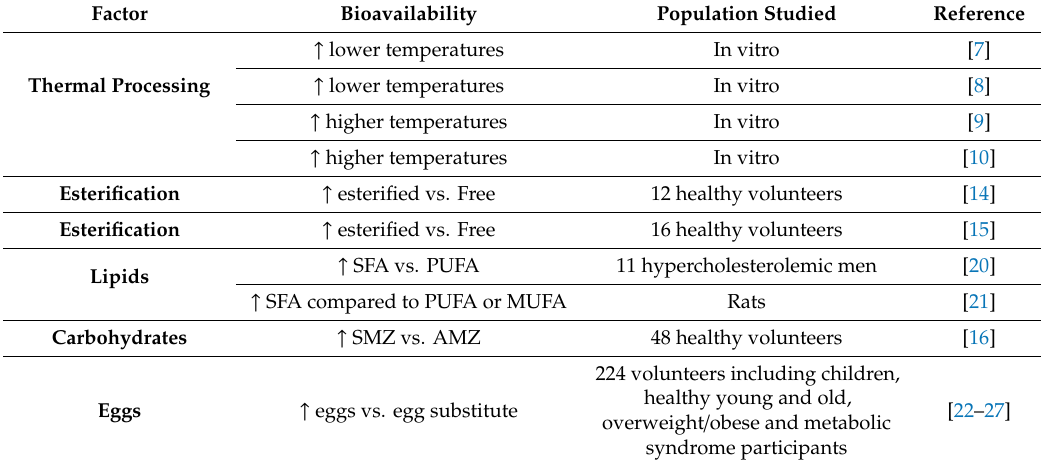
Table 1. Factors a ff ecting zeaxanthin